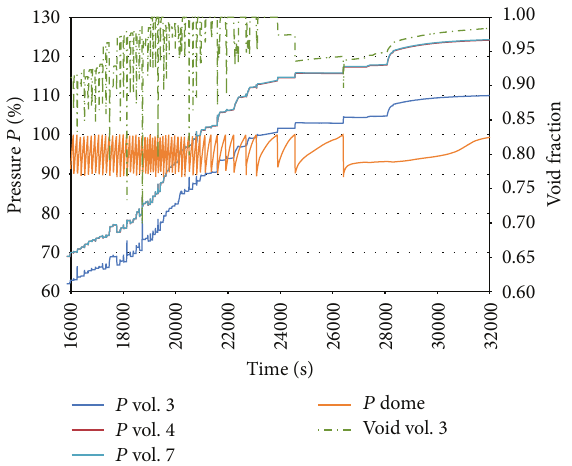
Figure 13: Temperature evolution on cladding and debris bed at RPV wall at the nodes where peak values were reached, and total heat generated due to